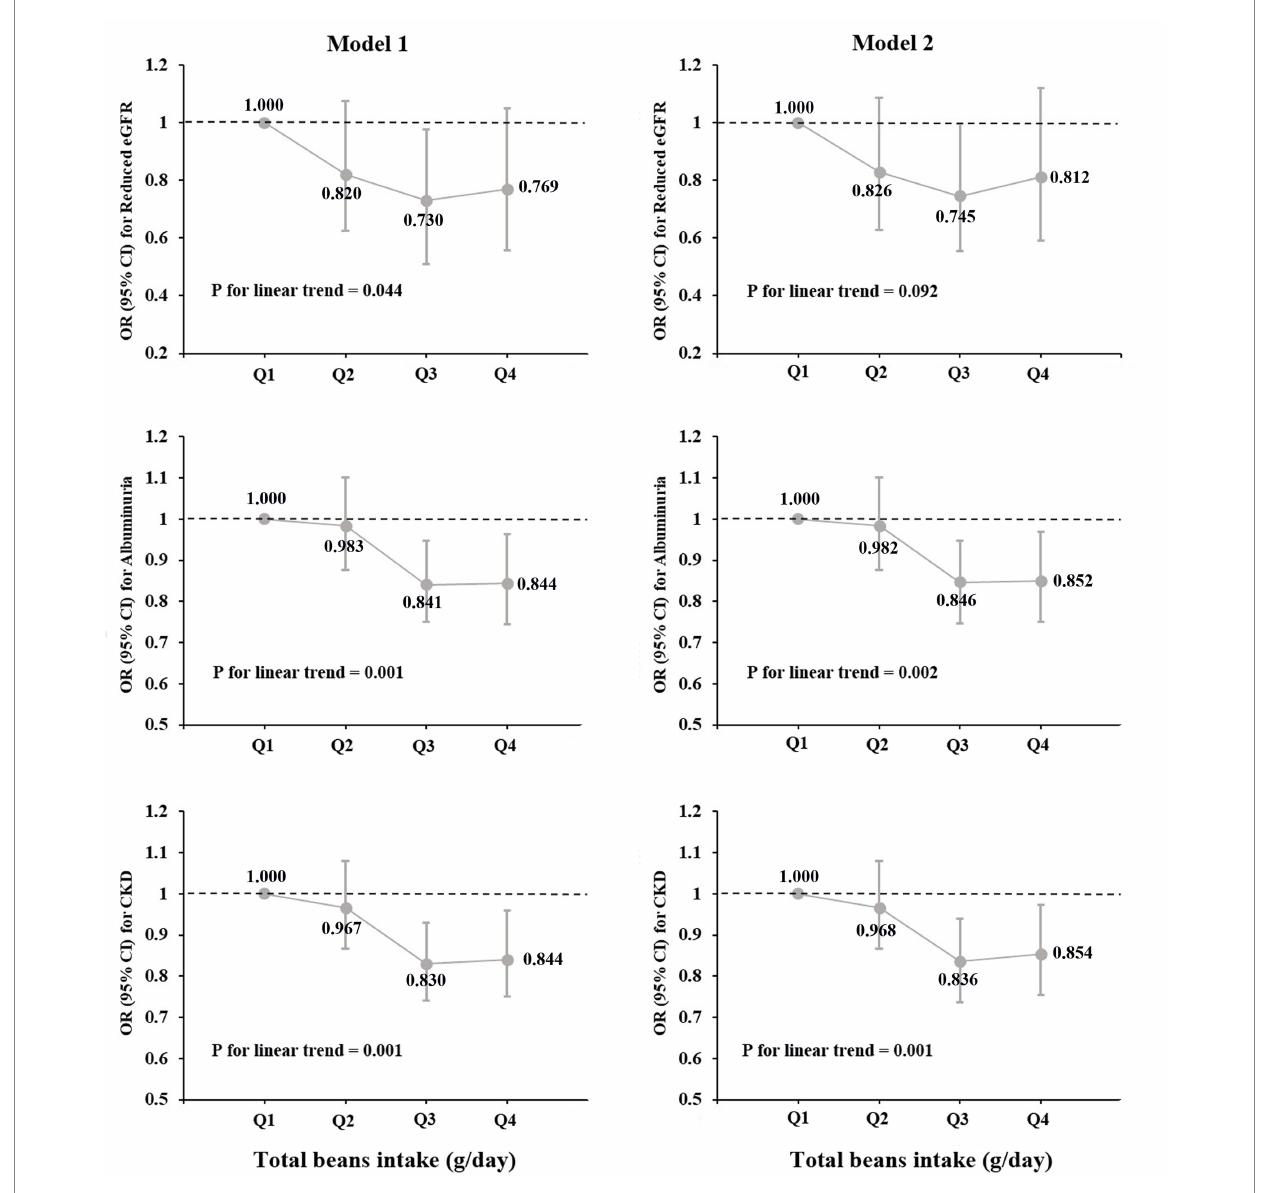
FIGURE 2 Prevalence of reduced eGFR, albuminuria and CKD by quartiles of total beans intake ( OR and 95% CI